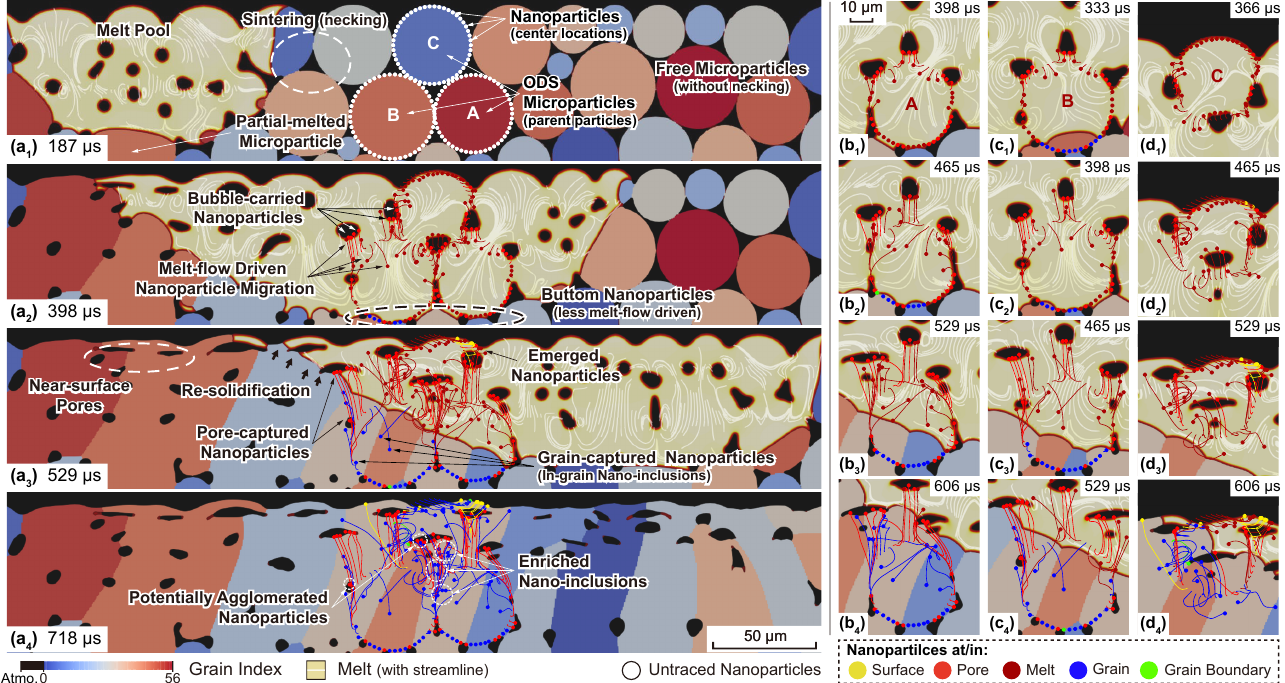
Nanopartilces at/in: Melt (with streamline) Grain Index Pore Grain Grain BoundaryMelt Untraced Nanoparticles 0 56Atmo. Figure 3. Simulation results of an LPBF-processed ferritic PM2000 powder bed with P l = 160 W and v l = 800 mm/s, in which three particles are marked and decorated with Y 2 O 3 nanoparticles. Transient microstructure, nanoparticle tracing, and feature phenomena are presented at ( a 1 ) 197 µ s, ( a 2 ) 398 µ s, ( a 3 ) 529 µ s, ( a 4 ) 718 µ s . Trajectories of nanoparticles are respectively depicted for nanoparticles initially located on different parent particle at corresponding timestep, i.e., on parent particle A at ( b 1 ) 398 µ s, ( b 2 ) 465 µ s, ( b 3 ) 529 µ s, ( b 4 ) 606 µ s; on parent particle B at ( c 1 ) 333 µ s, ( c 2 ) 398 µ s, ( c 3 ) 465 µ s, ( c 4 ) 529 µ s; and on parent particle C at ( d 1 ) 366 µ s, ( d 2 ) 465 µ s, ( d 3 ) 529 µ s, ( d 4 ) 606 µ s. Notice that the trace markers at the end of the trajectory only indicate the central location of the nanoparticle at the time rather than the size.